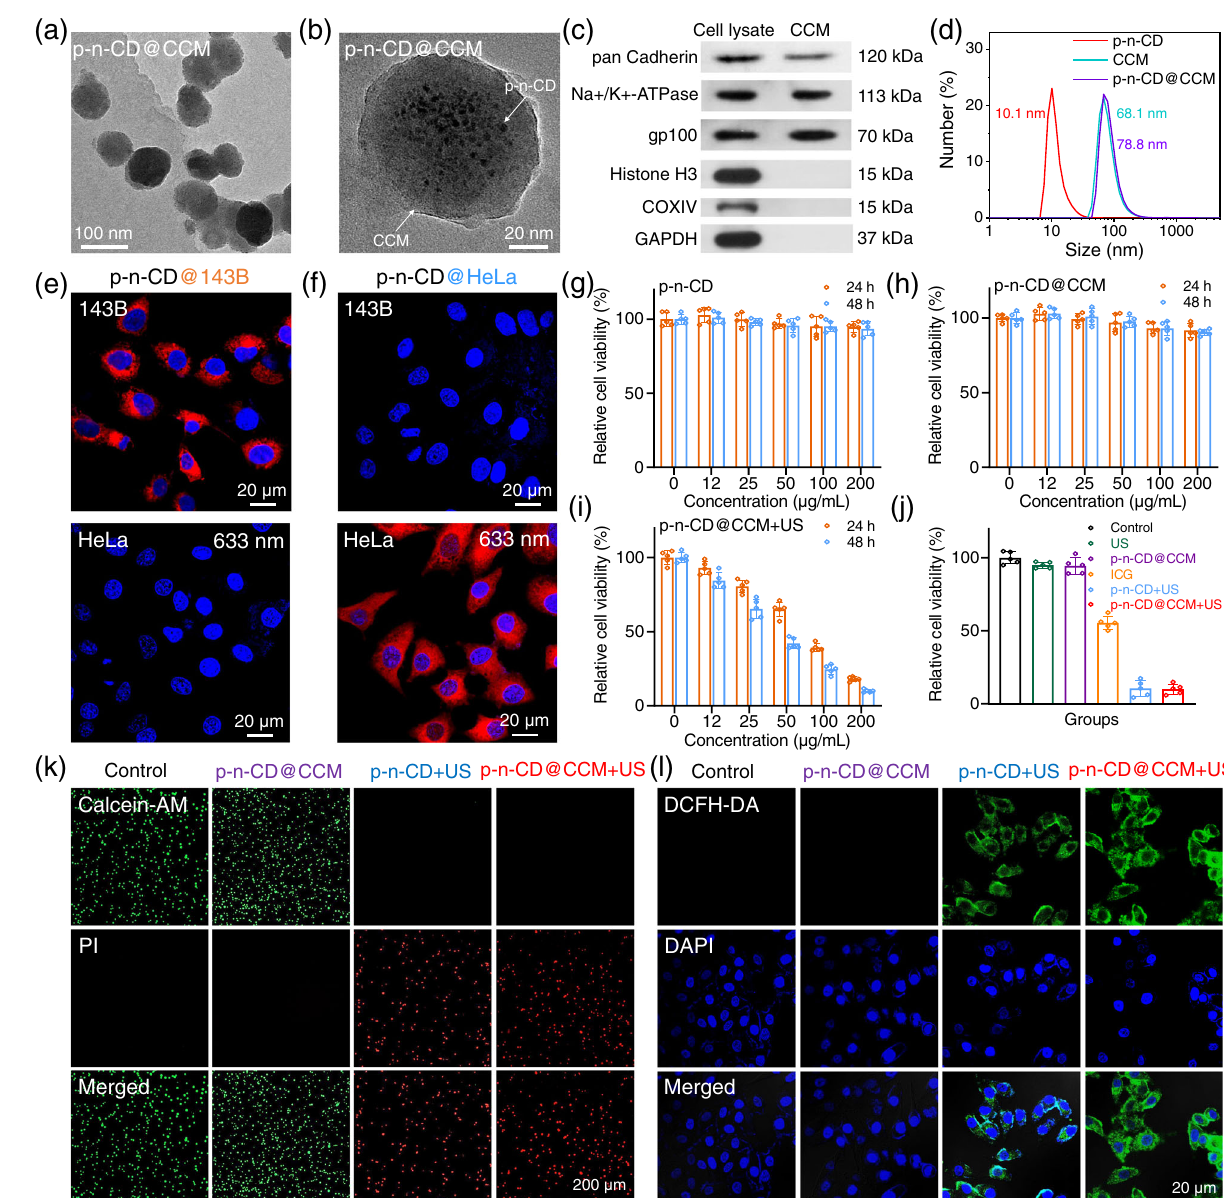
Fig. 5 | In vitro precision SDT of p – n-CD@CCM. a , b TEM images of p – n- CD@CCM. c Westernblottinganalysisofcelllysateand CCMbymembrane-speci fi c (pan-cadherin, Na+/K+-ATPase, and gp100) and intracellular protein markers (His- tone H3 and COXIV). d Hydrodynamic diameter of free p – n-CDs, CCM, and p – n- CD@CCM. e , f Cancer-speci fi cconfocalimagesof143BandHelacellsincubatedwith p – n-CD@Helaorp – n-CD@143B,respectively. g , h Relativecellviabilityof143Bcells incubated with free p – n-CDs ( g ) or p – n-CD@CCM ( h ) at varied concentrations